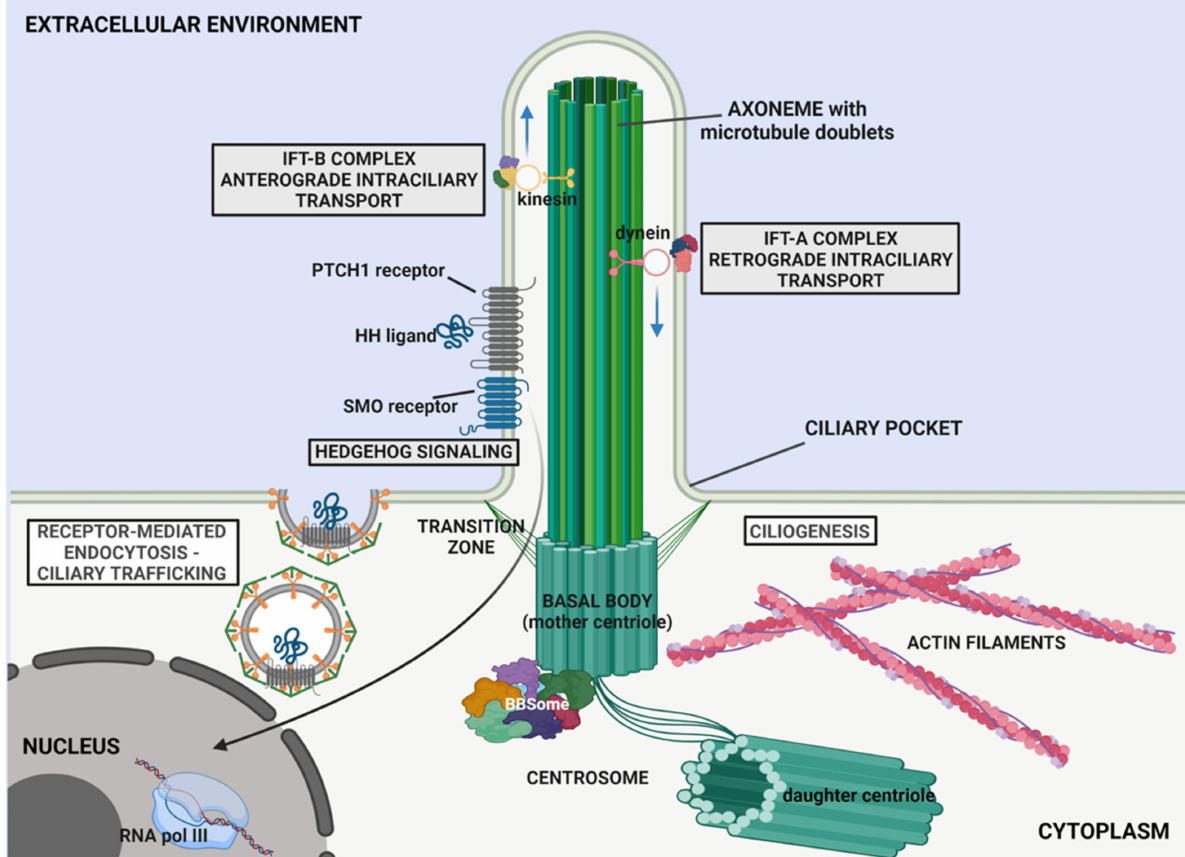
Figure 1. Schematic representation of the primary cilium structure. The primary cilium protrudes from the apical surface of cells, with a central shaft composed of nine microtubule doublets (axoneme) that extend from the basal body, a modified centrosomal mother centriole. The transition zone (TZ) is characterised by Y-shaped links connecting the axonemal microtubules to the ciliary membrane contributing to compartmentalisation of the organelle. Proteins and other cargos are transported from the basal body to the tip of axoneme by anterograde intraflagellar transport (IFT) through IFT-B complex and kinesin-motor protein; whereas dynein-motor protein associated with IFT-A complex contributes to retrograde IFT (from the tip to the basal body). The basal body associates with the BBSome, a heptameric complex involved in ciliogenesis and ciliary trafficking. The ciliary membrane contains specialised lipids, proteins and receptors (e.g., Patched 1 (PTCH1) receptor and the associated Smoothened (SMO) co-receptor, that bind different hedgehog, HH, ligands), through which the cilium coordinates different pathways (e.g., Hedgehog signalling). See text for further